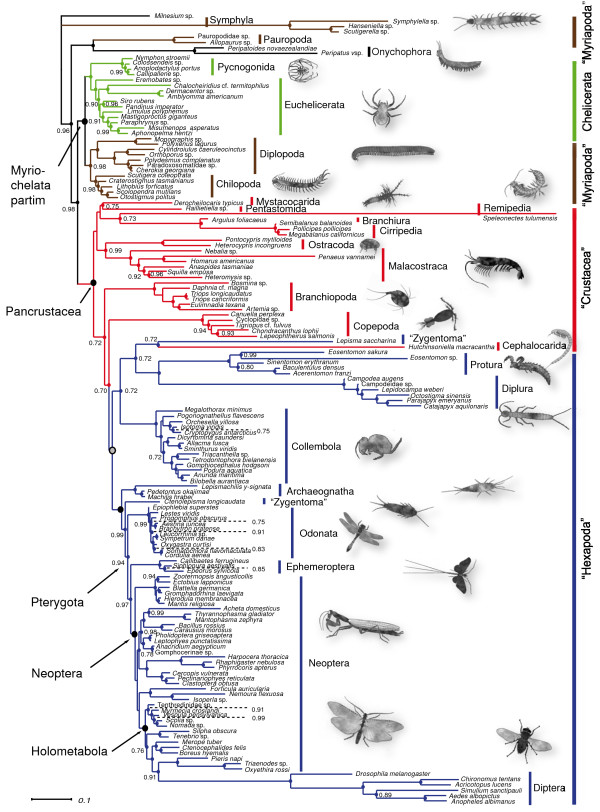
Time-homogeneous consensus tree. Consensus tree from 18,000 sampled trees of the time-homogeneous substitution process inferred by PHASE-2.0, graphically processed with Adobe Illustrator CS2. Support values below 0.70 are not shown (nodes without dots), nodes with a maximum posterior probability (pP) of 1.0 are represented by dots only. The grey dot indicates the clade containing all hexapod taxa including Hutchinsoniella (Crustacea) + Lepisma (Zygentoma); its node value is pP 0.58. Quotation marks indicate that monophyly is not supported in the given tree.